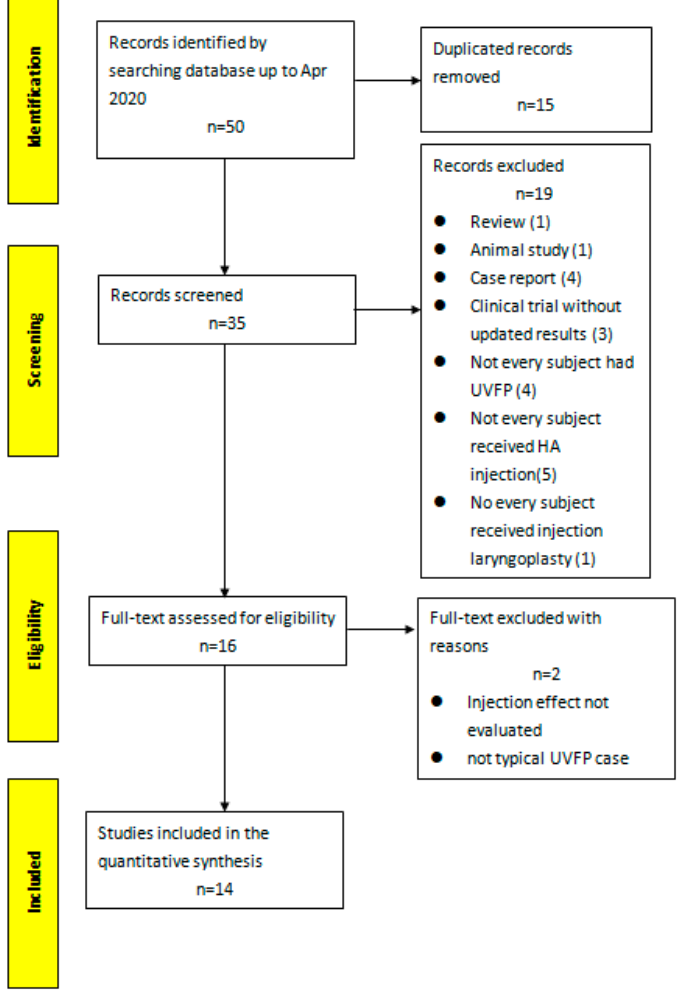
Figure 1. Flowchart diagram of literature search and selection. Inclusion and exclusion criteria are listed in Table 1.